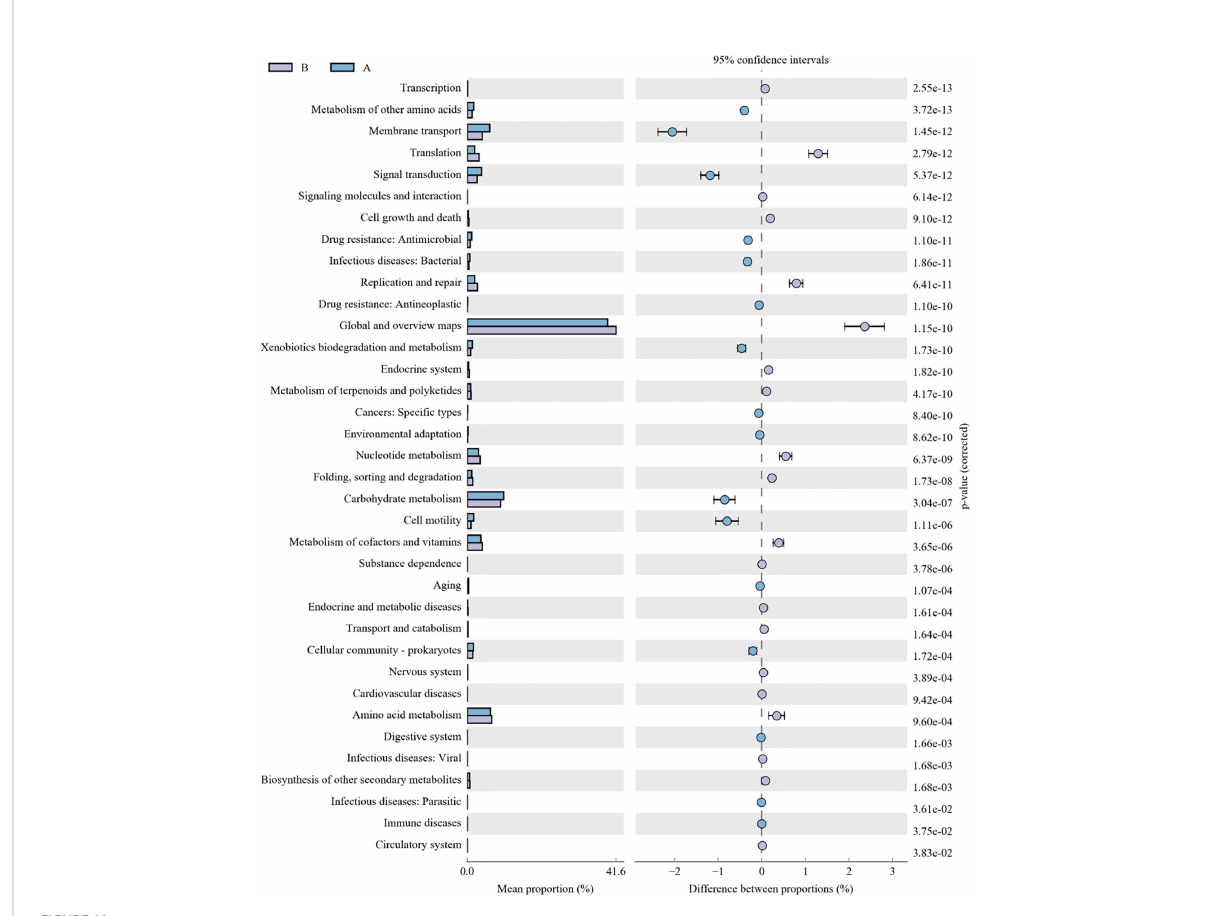
FIGURE 11 KEGG analysis of LRTI children with/without hematological malignancies. A re fl ect BALF samples of LRTI children with hematological malignancies; B re fl ect BALF samples of LRTI children without hematological